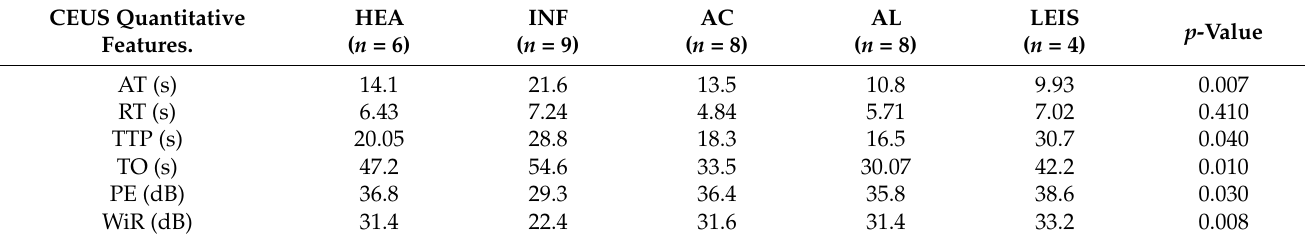
Table 3. Quantitative parameters reported as mean values of contrast enhanced ultrasound (CEUS) examination for healthy (HEA), inflammatory (INF), adenocarcinoma (AC), lymphoma (AL), and leiomyosarcoma (LEIS). Parameters considered include arrival time (AT), rising time (RT), time to peak (TTP), time to fall (TO), peak enhancement (PE) and wash-in rate (WiR). CEUS Quantitative